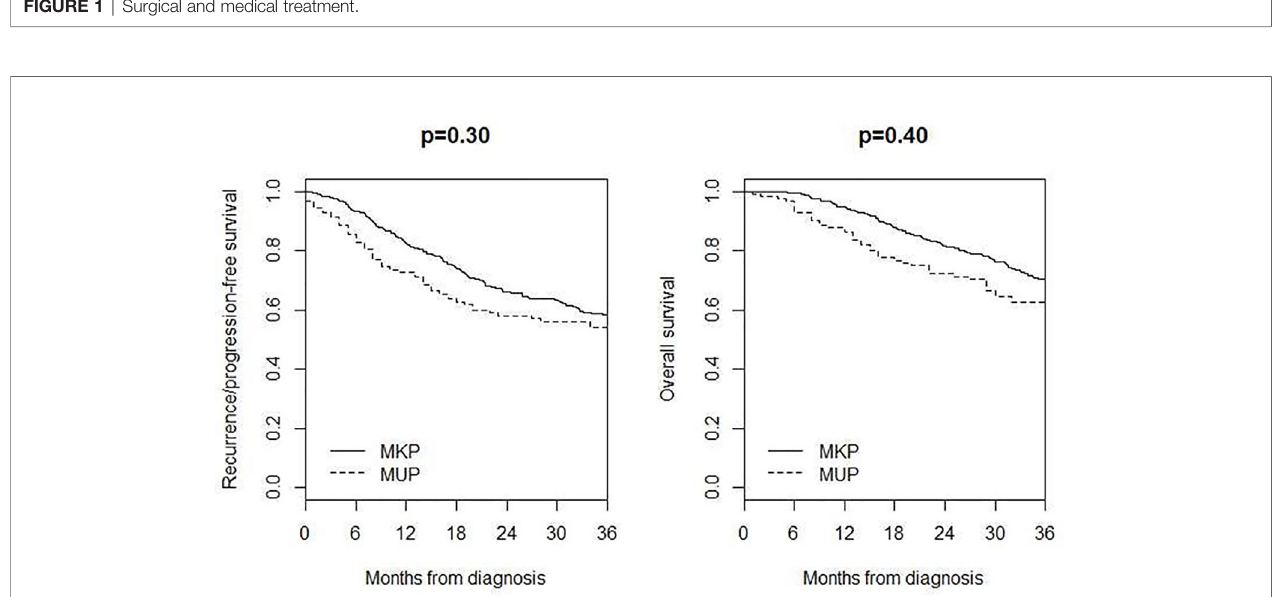
FIGURE 2 | Overall survival and recurrence/progression-free survival in MUP and MKP